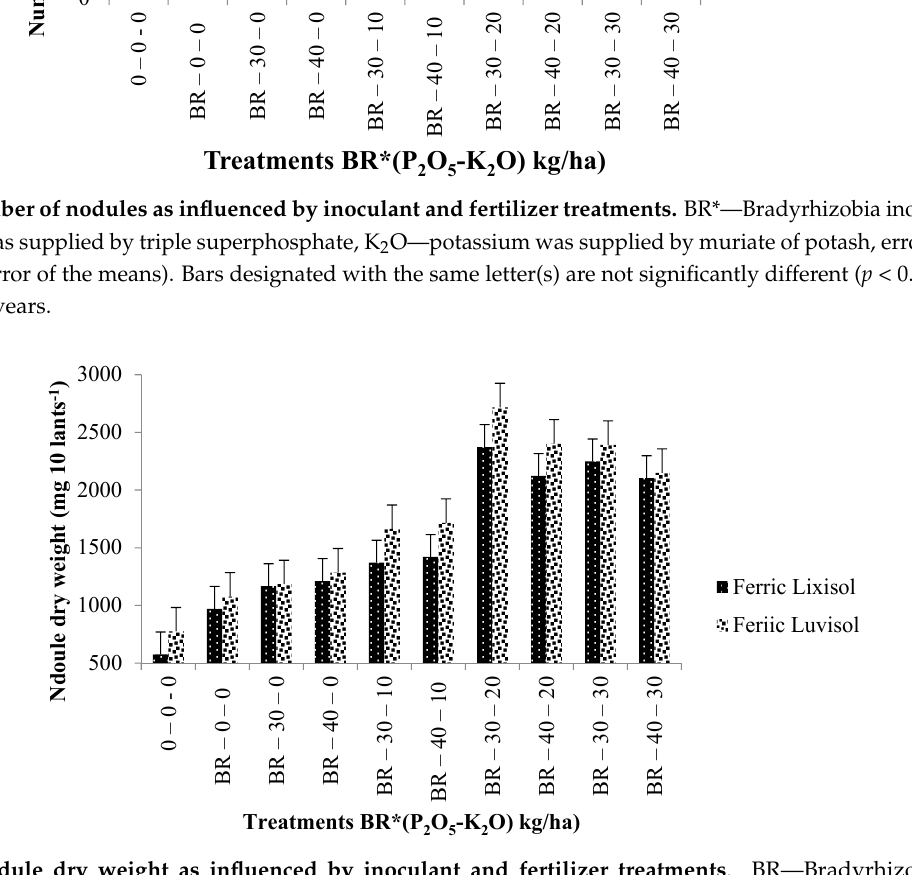
Figure 2. Nodule dry weight as influenced by inoculant and fertilizer treatments . BR—Bradyrhizobia inoculant, P 2 O 5— Phosphorus supplied by triple superphosphate, K 2 O—potassium was supplied by muriate of potash, error bars denotes the standard error of the means). Values are means of two years.